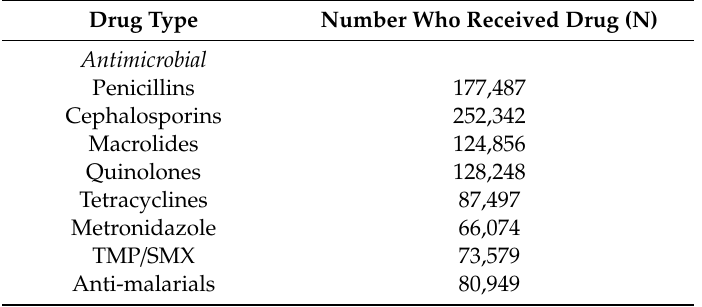
Table 2. Total number of patients who received drugs during study